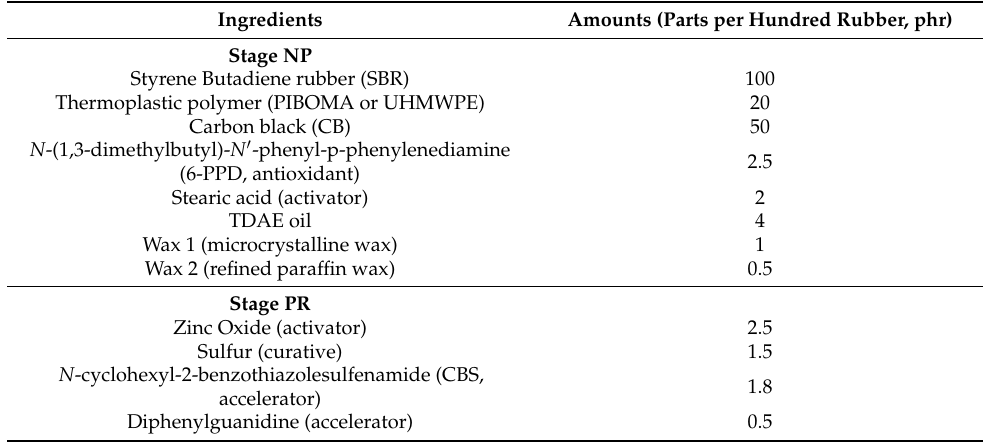
Table 2. Formulation of the rubber